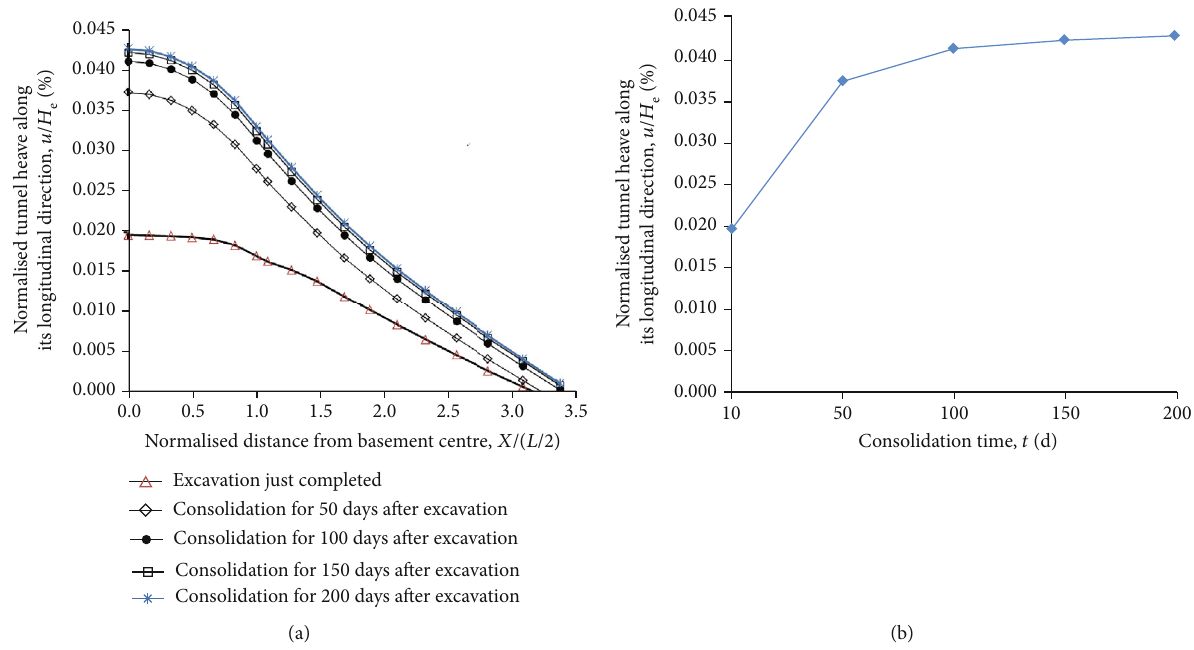
Figure 9: E ff ect of consolidation time on (a) tunnel heave in longitudinal direction and (b) maximum tunnel heave in clay.